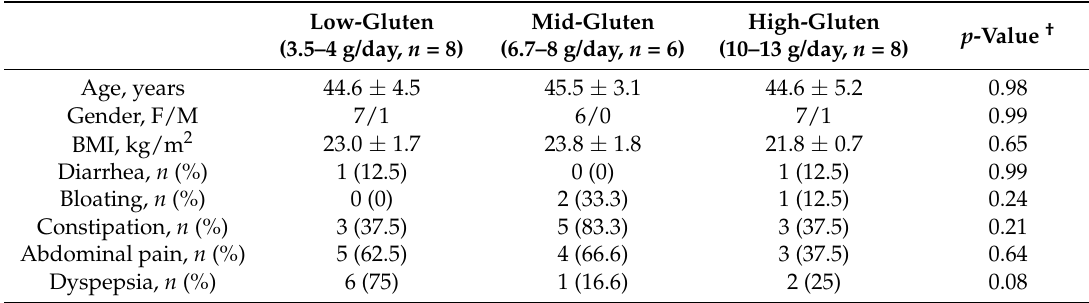
Table 3. General characteristics of the group of patients at baseline 1